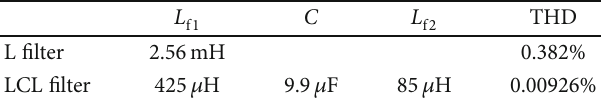
Table 4: Filter L and LCL data and THD.